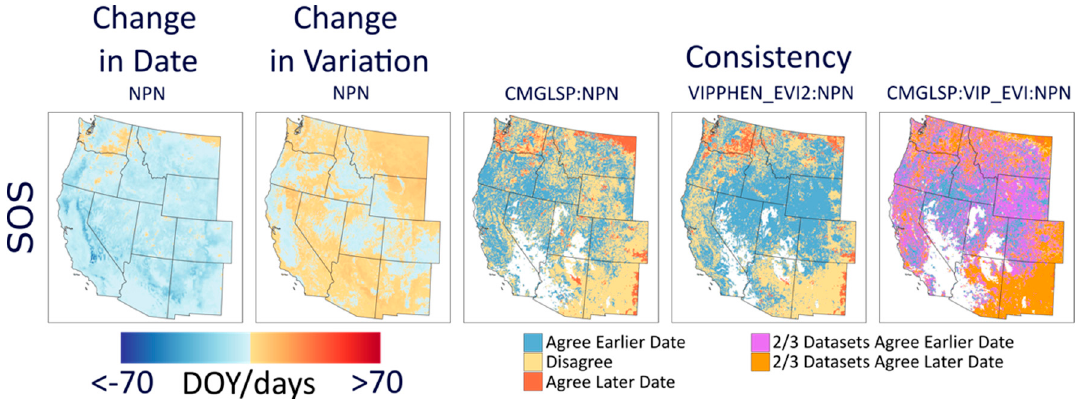
Figure A2. Change in SOS date and variation of NPN from 1982 to 2016 alongside consistency with CMGLSP and VIPPHEN_EVI2. Negative values correspond to earlier dates (or fewer days) and positive values to later dates (or more days). Consistency shows dataset agreement with regards to the direction of change. Change in date is the regressed trend slope multiplied by the number of years. Change in variation is the regressed trend slope of the absolute value of the residuals multiplied by the number of years.